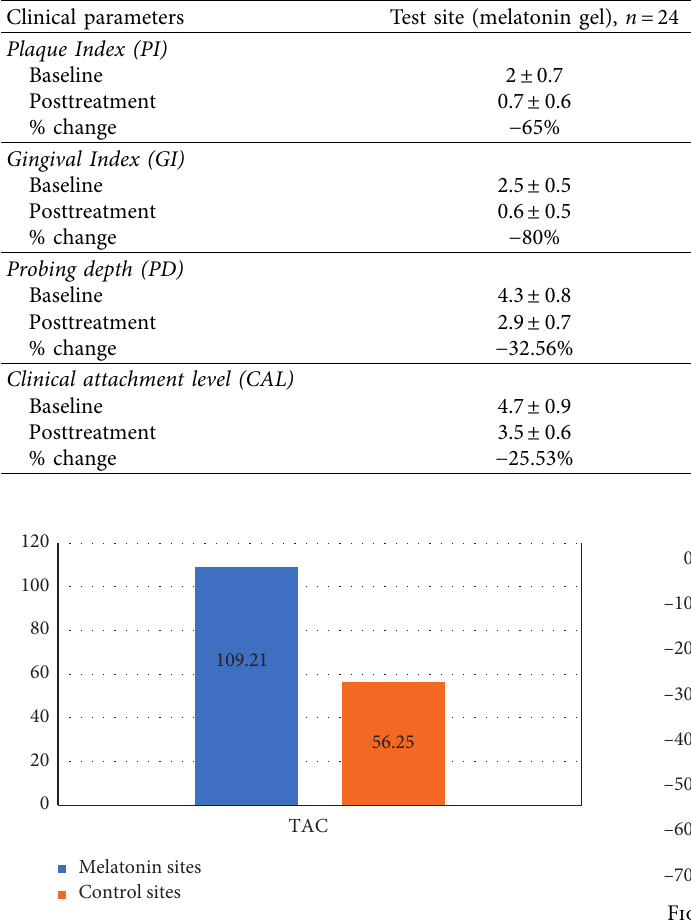
Figure 2: Bar chart of TAC percent change in both sites.